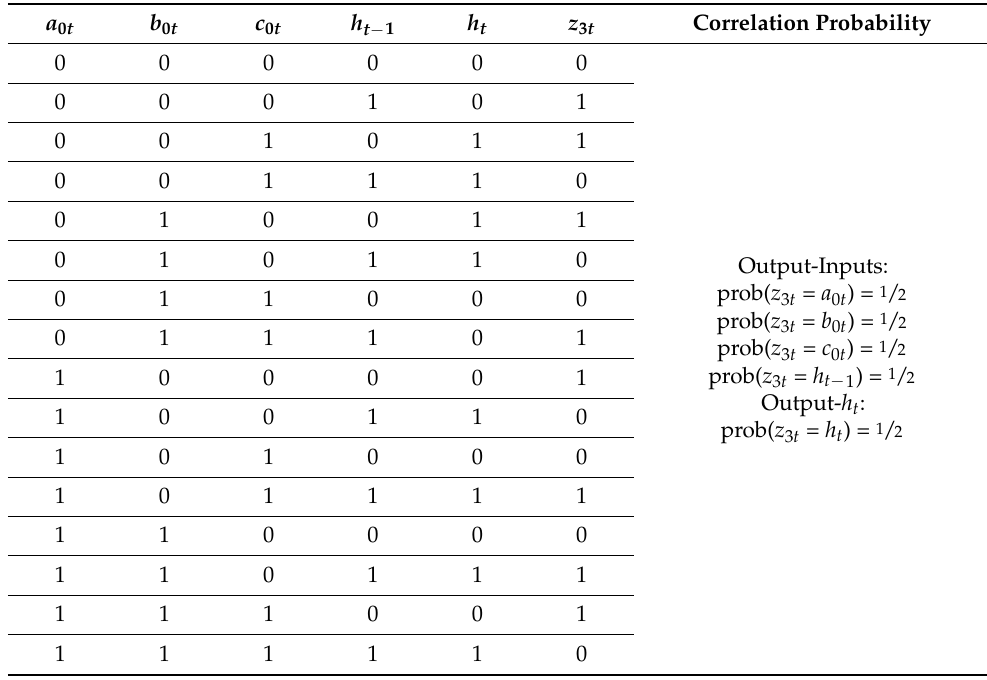
Figure 10. The output sequence generator 3. The initial state of the bits, h t − 1 , is defined to be 0. The correlation probabilities of the output-inputs and the output- h t of OSG 3 are both 1/2, which are demonstrated in Table 9. Table 9. Correlation probability of OSG 3 .